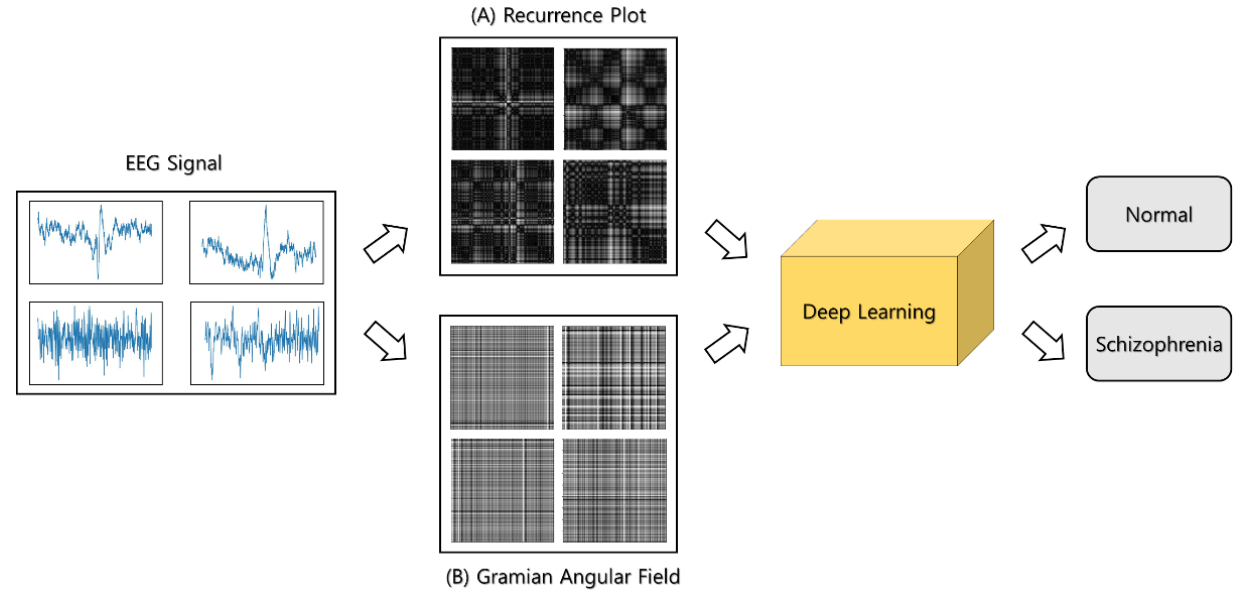
Figure 2. Image conversion and deep learning process of EEG data.